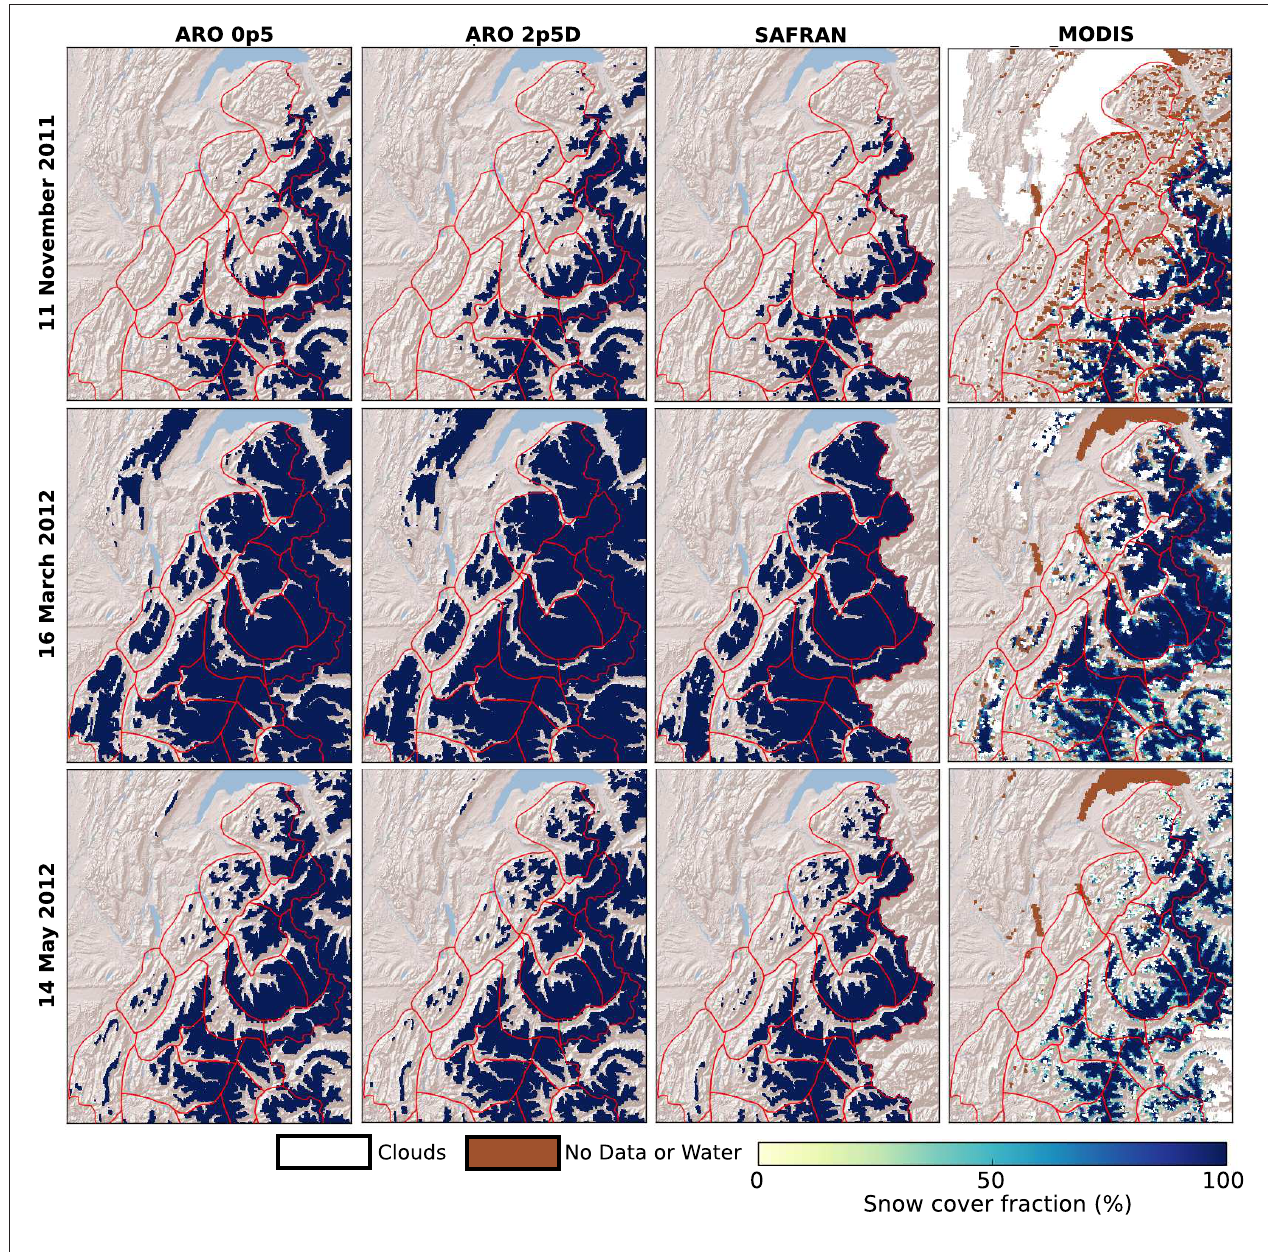
FIGURE 10 | Maps of snow covered fractions simulated by Crocus driven by the three forcing datasets and observed by MODIS (Right) for three dates of winter 2011–2012: 11 November 2011 (Top) , 16 March 2012 (Middle) and 14 May 2012 (Bottom) . Results of SAFRAN experiment are only shown within the limit of the massifs (red